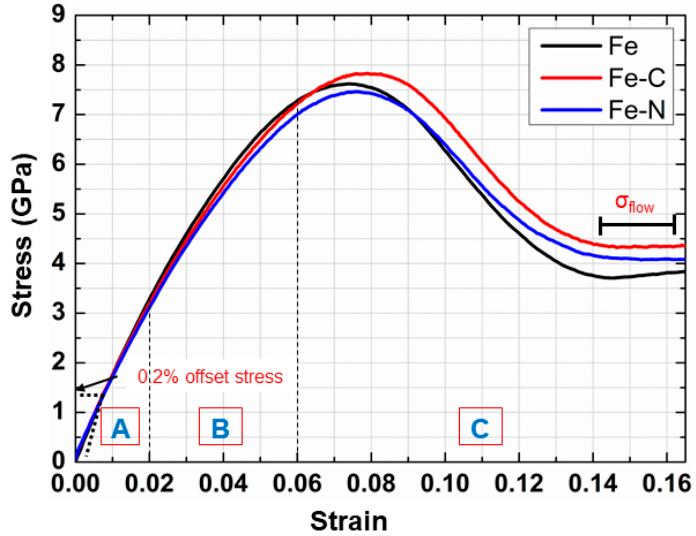
Figure 5. Typical stress–strain curves during tensile deformation of nc samples at strain rate 5 × 10 8 s − 1 .